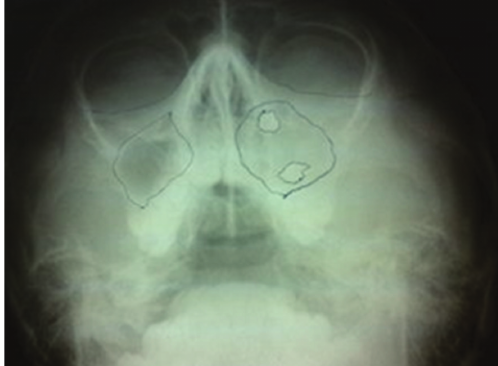
Figure 2: Paranasal sinus view.